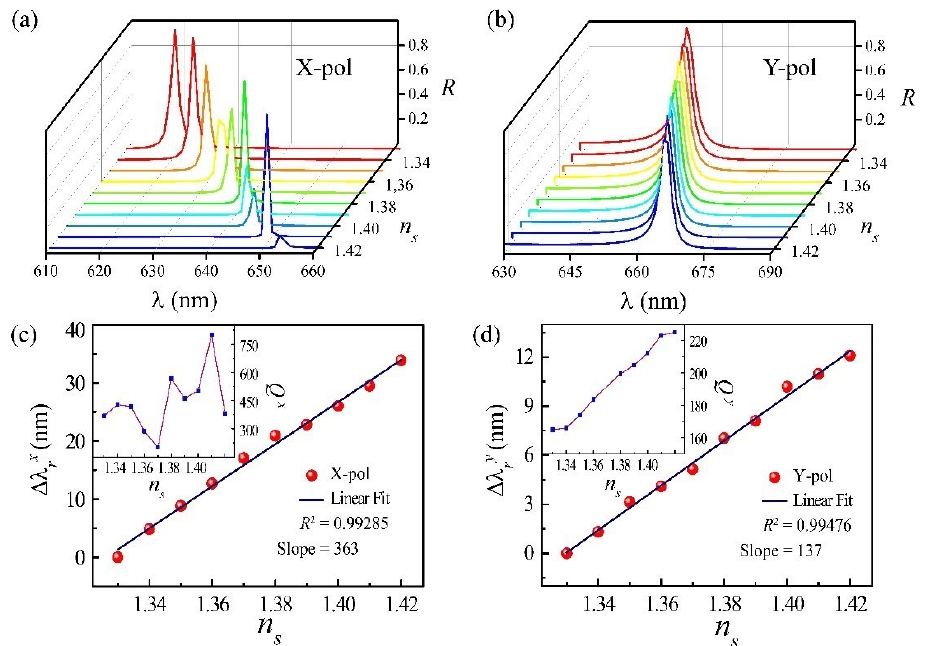
Figure 5. Effect of n s in the optical responses. ( a , b ) Show the variation in R with the λ for different n s in X-pol and Y-pol lights, respectively. ( c , d ) Show the resonance peak shift ( ∆ λ ) with the n s with insets show the Q -factor corresponding to each n s for both X-pol and Y-pol lights, respectively.